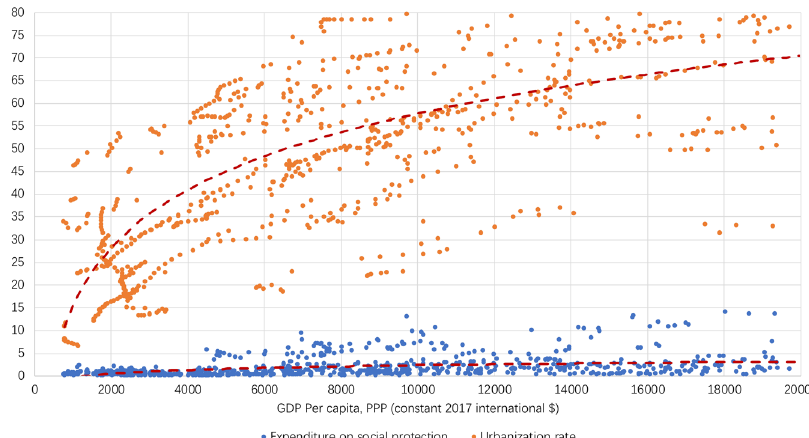
Fig. 1 Expenditure on social protection, urbanization rate, and GDP per capita. This reports the 1990 – 2017 social protection expenditure and urbanization rate for 100 countries. Notes: (1) The social protection expenditure (% of GDP) is sourced from the IMF GFS Database. (2) The urbanization rate and GDP per capita are sourced from the WDI Database of the World Bank (2017).